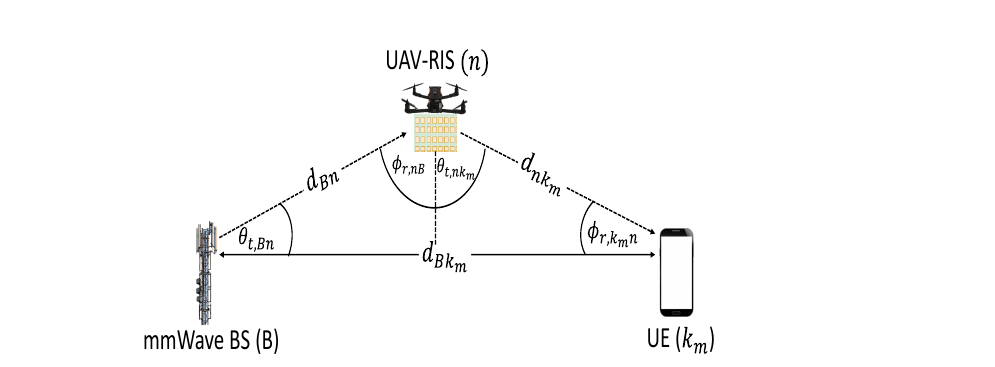
Figure 2. Schematic diagram of the mmWave BS, UAV mounted RIS, UE communication links. ( d ) are the path losses of the LoS and NLoS paths ) and L In (2), L LoS ( d Bk NLoS Bk m m